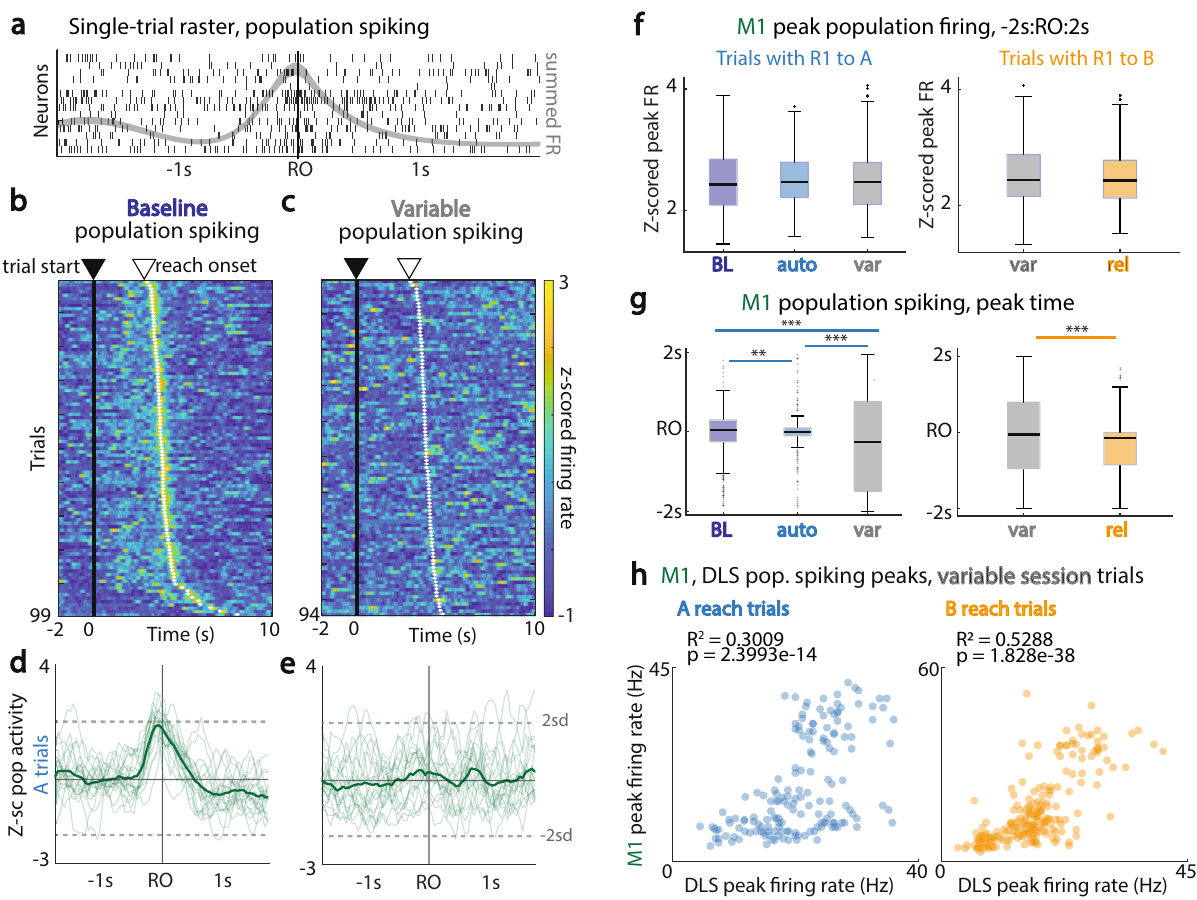
Fig. 4 M1 single-trial population spiking activity loses temporal consistency with relearning. a Example single trial raster plot with the population spiking average overlaid (summed spike counts, 50 ms time bins with spline fi t). b M1 z-scored single-trial population spiking activity across a session; trials sorted by time from trial start to reach onset. c Same as ( a ), example animal variable session. d Baseline session z-scored population spiking in M1 around reach onset. e Variable session, example A reach trials. f Magnitude of trial peak population fi ring rate (z-scored sum of spiking over time) within − 2 s to 2 s around fi rst reach onset in M1 units for trials with fi rst reach to A (left) and trials with fi rst reach to B (right). R1 to A: BL, n = 291 trials; auto, n = 256 trials; var, n = 169 trials. R1 to B: var, n = 226 trials; rel, n = 214 trials. Data are presented as box plots with 25th, 50th, and 75th percentiles. g Time of population fi ring peak for the same trials, in same window as for ( f ). Data are presented as box plots with 25th, 50th, and 75th percentiles. h Variable session, covariation of M1-DLS fi ring across trials even with variable timing of peak. *<0.05; **<0.01; ***<0.001, Bartlett ’ s test of homoscedasticity. Source data are provided as a Source Data fi